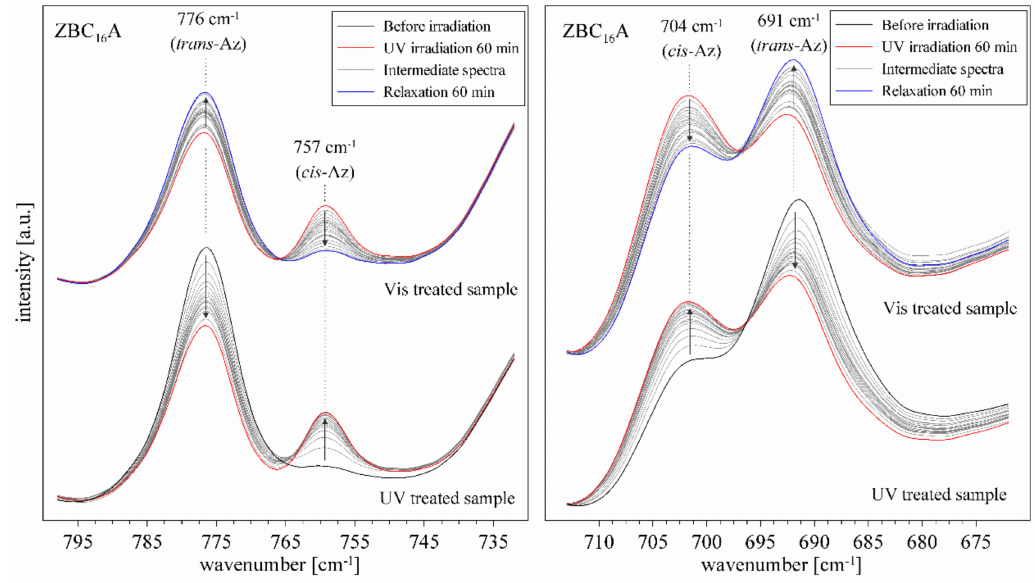
Figure 8. FTIR spectra of ZBC 16 A sample under UV and Vis treatment; arrows indicate the direction of the spectrum